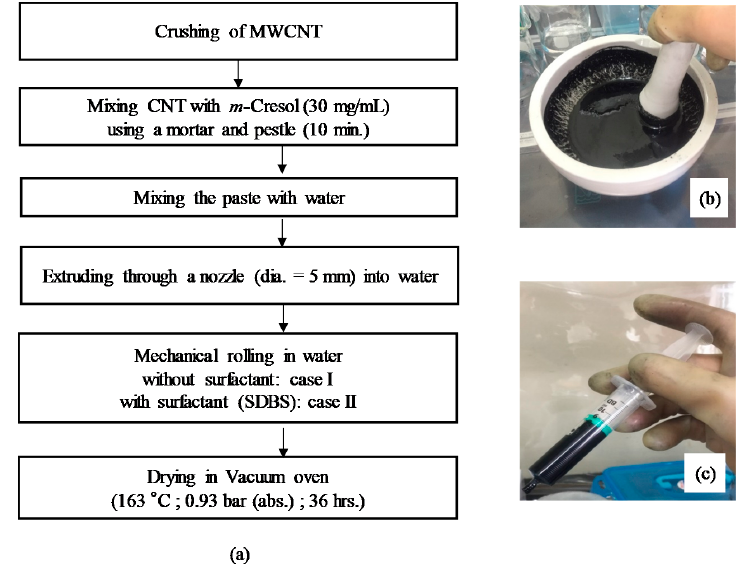
Figure 2. Flow diagram of preparation process of carbon nanotube (CNT) microbeads ( a ); mortar ( b ) and syringe for extrusion ( c ) used in the process.